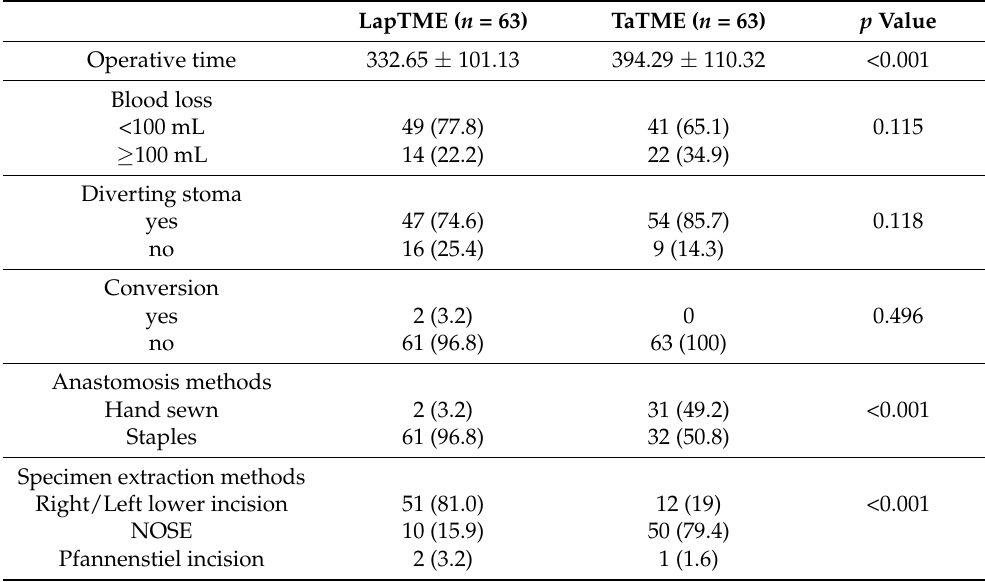
Table 2. Post-matching of operative parameters among patients with low rectal cancer underwent restorative